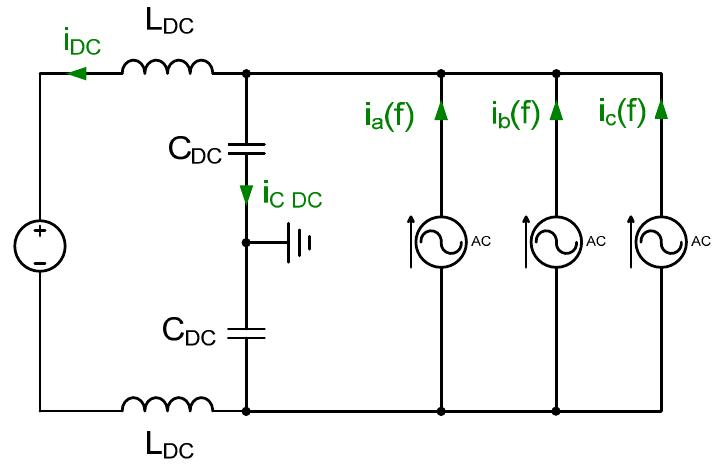
Figure 8. DC filter with equivalent current sources.